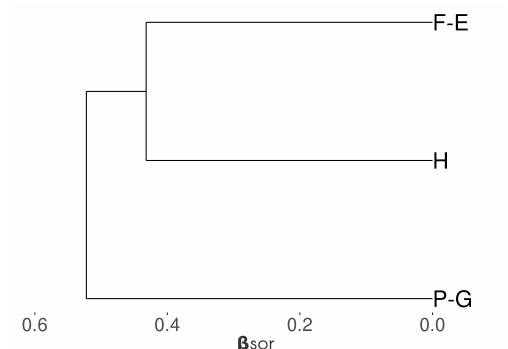
Figure 4. Dendrogram of the three types of SNH (H: hedgerows, F-E: forest edges and P-G: permanent grasslands) ranked according to Sørensen’s index ( β sor ) calculated between the three wild bee communities. β sor is lower between H and F-E than between P-G and the two wooded SNH, indicating a lower difference in species composition in these